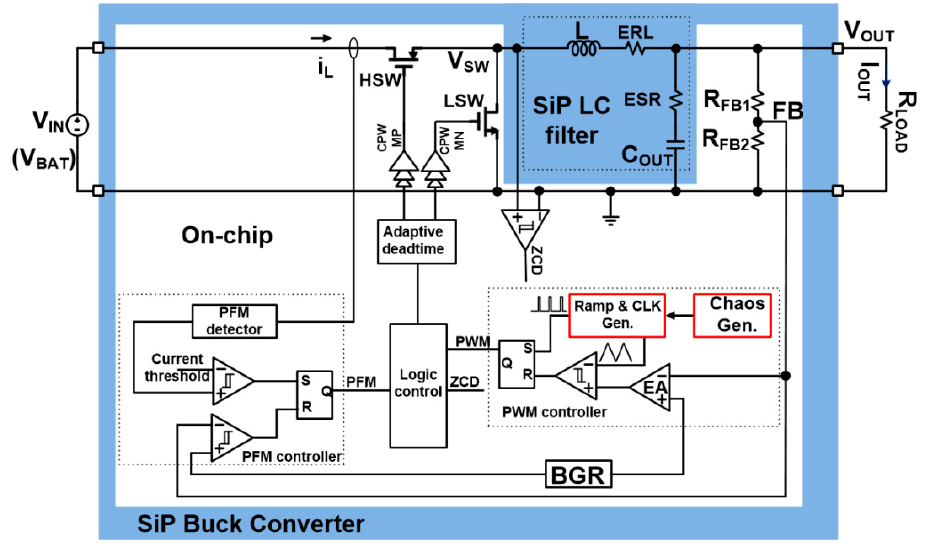
Figure 1. System-in-package (SiP) buck converter with chaos-based electromagnetic interference (EMI) reduction. The highlighted chaotic ramp and clock generator forces the converter to operate in chaotic mode for EMI reduction.